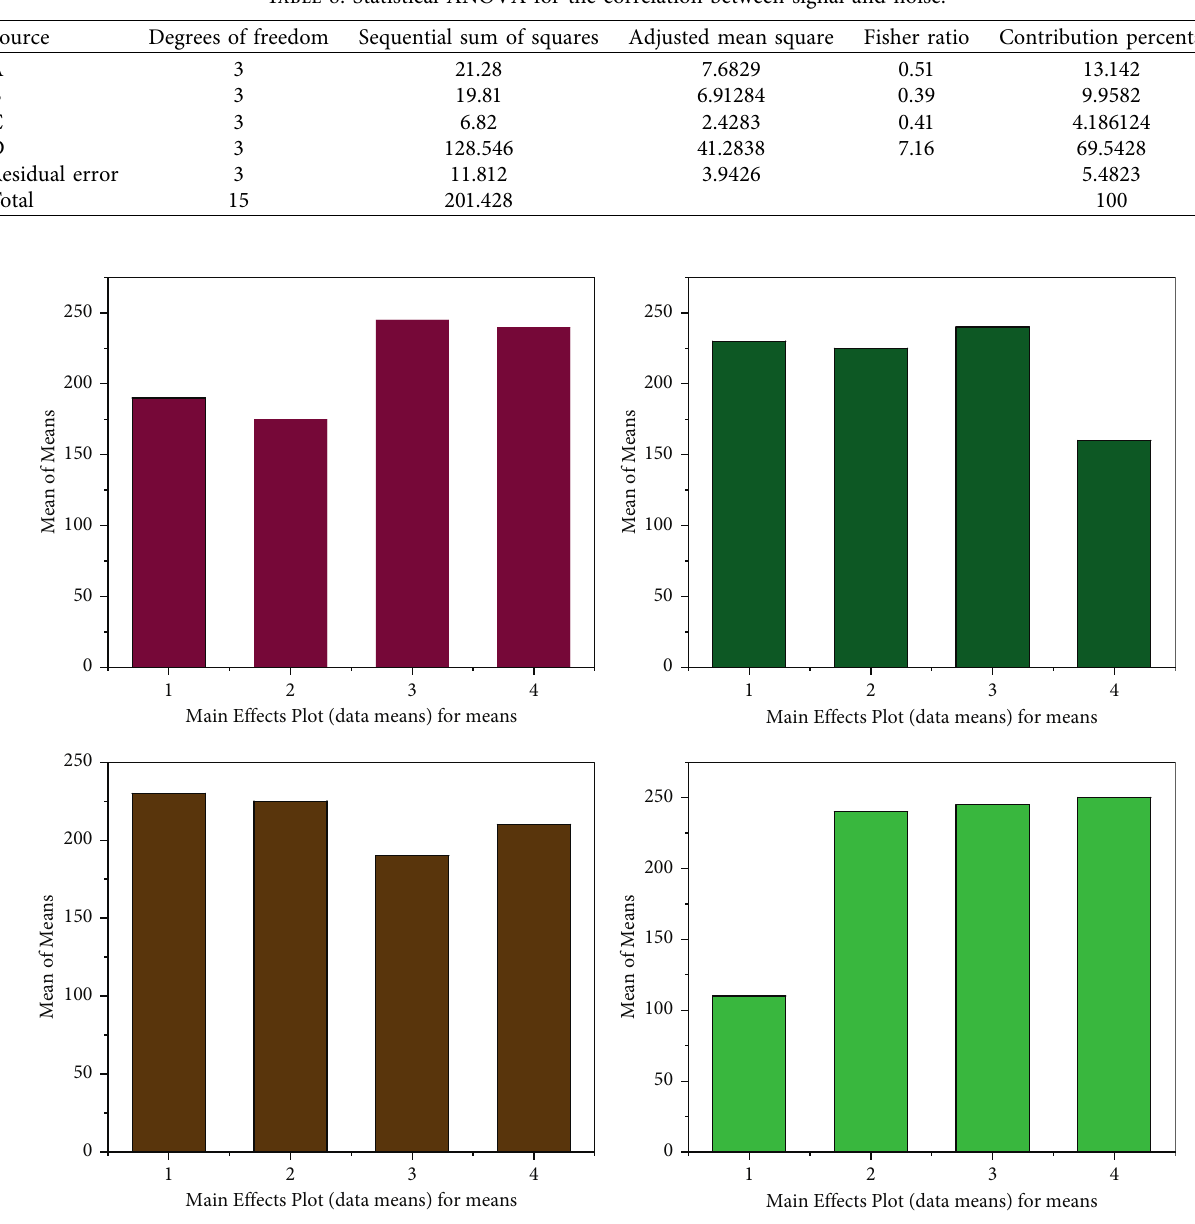
Figure 4: Main effects of the plot for